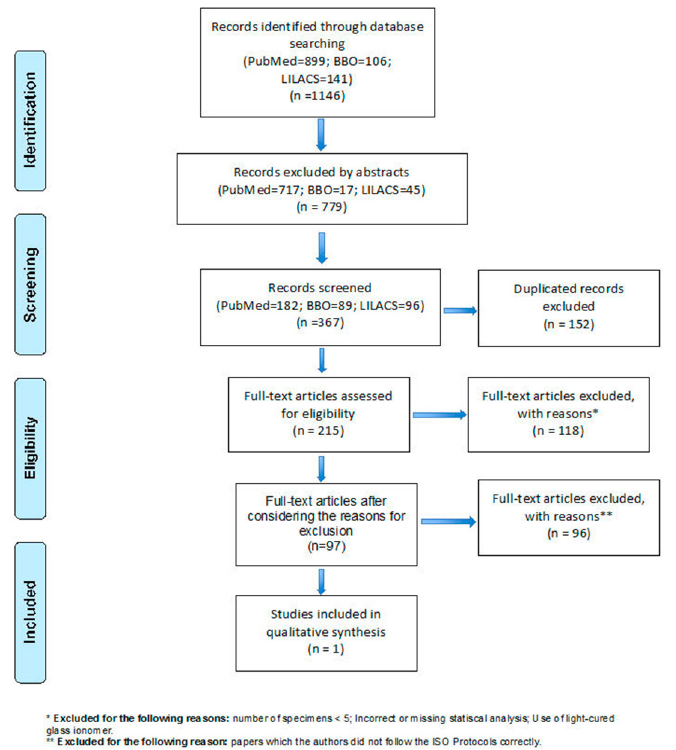
Figure 3- Flowchart showing the inclusion process of the studies that composed in the